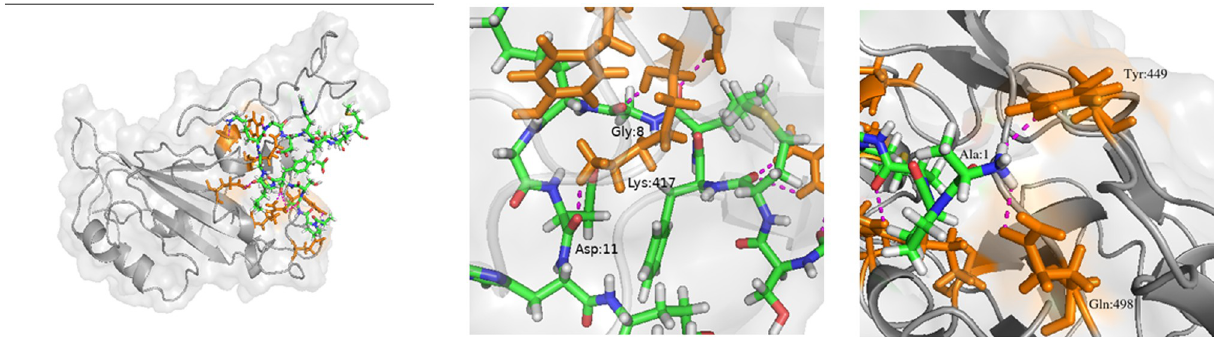
Fig 2. (a) Peptide 7-SARS-CoV-2 RBD complex. Peptide 7 (green, blue and white liquorice), RBD (grey) and residues in RBD which interact with Peptide 7 are highlighted (orange liquorice). (b) Hydrogen bonding between Peptide 7 Gly8 and Asp11 with RBD Lys417. (c) Hydrogen bonding between Ala1 and